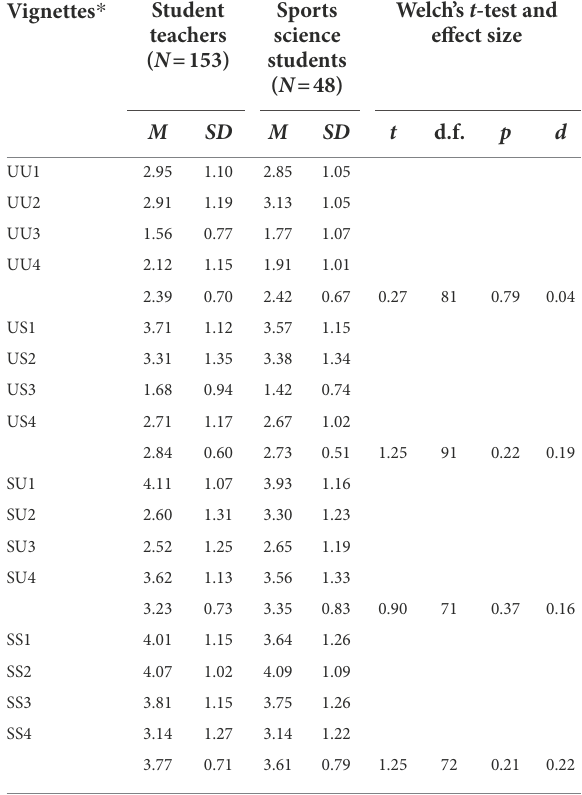
TABLE 2 Vignette ratings: descriptive statistics and group comparisons. Vignettes